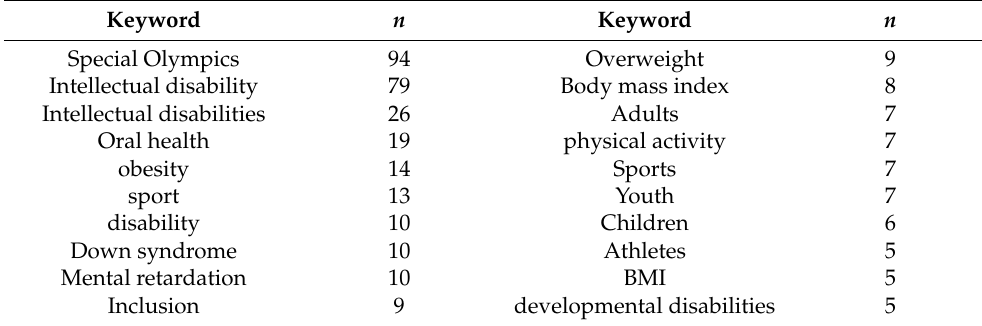
Table 3. Top 20 keywords in Special Olympics publications between 1978 and 4 March